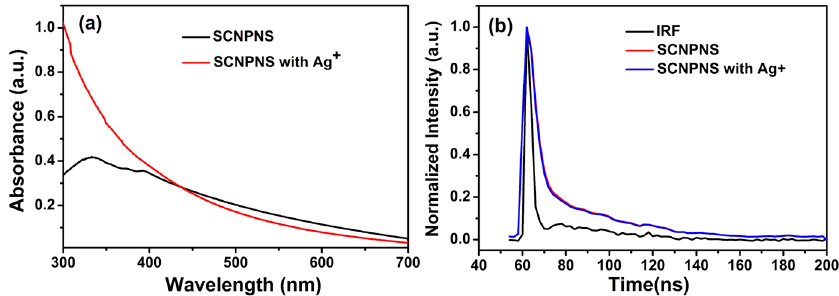
Figure 6. ( a ) UV–visible absorption spectra of SCNPNS in the absence and the presence of Ag + ions, ( b ) The photoluminescence (PL) decay plot of instrument response function (IRF) and SCNPNS in the absence and the presence of Ag + ions.